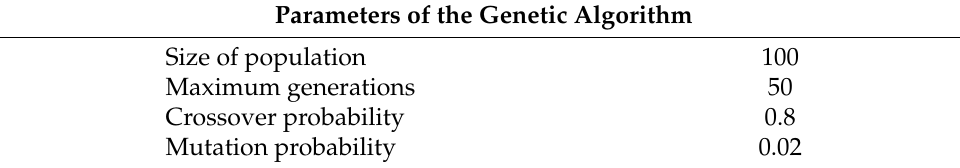
Table 4. Specific parameters of gain tuning algorithm.